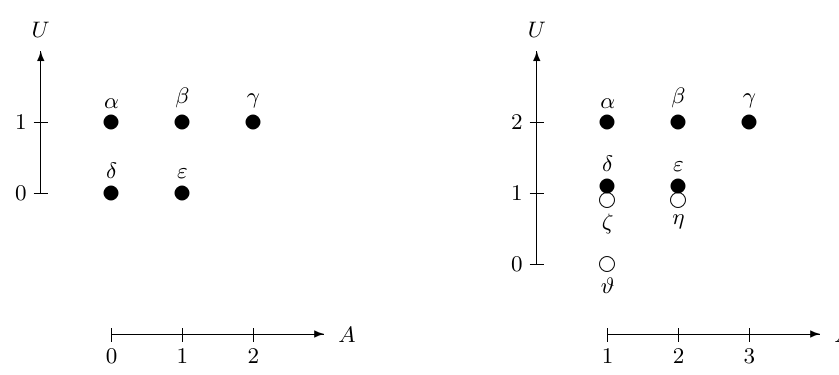
Figure 4: Classification of totally real dihedral and pure quintic